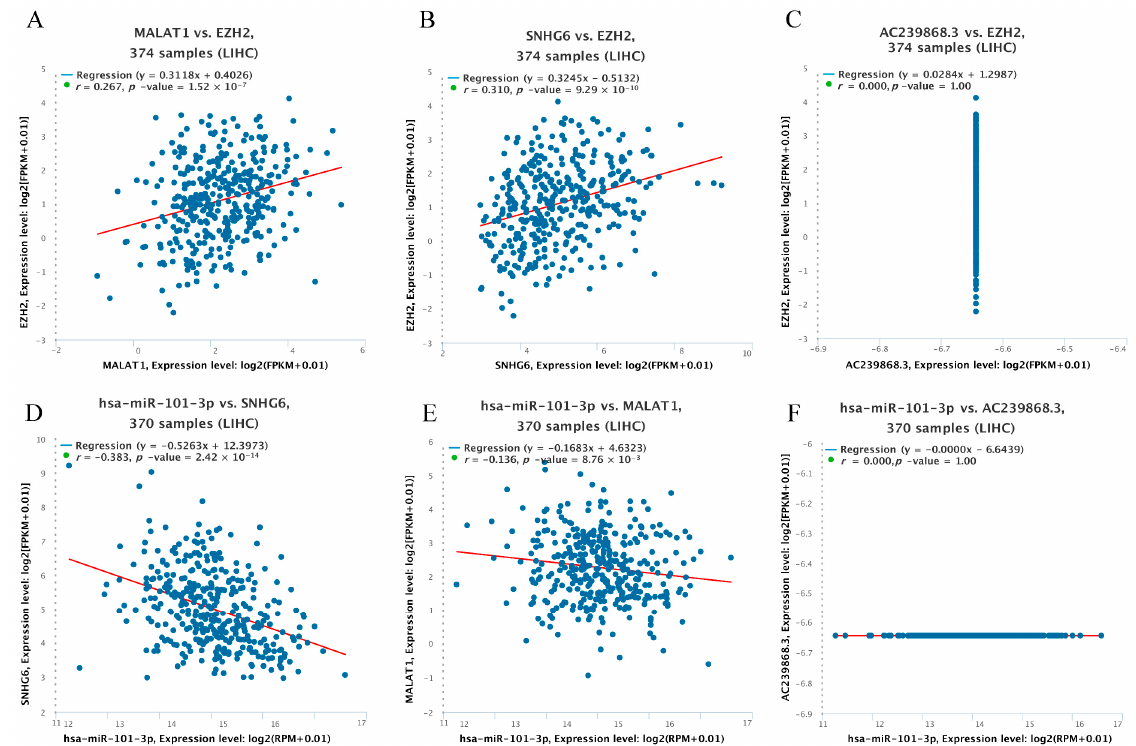
Figure 7. Correlation analysis between lncRNAs and hsa-miR-101-3p or between lncRNAs and EZH2 in HCC. ( A ) SNHG6 and EZH2, ( B ) MALA1 and EZH2, ( C ) AC239868.3 and EZH2, ( D ) hsa- miR-101-3p and SNHG6, ( E ) hsa-miR-101-3p and MALA1, and ( F ) hsa-miR-101-3p and AC239868.3.